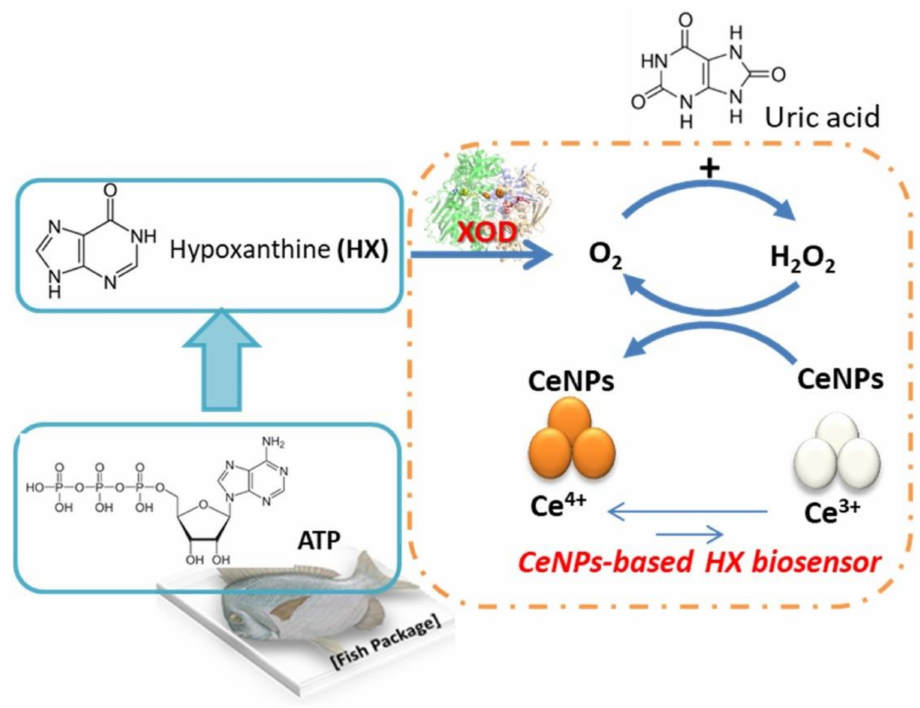
Figure 12. Ceria NPs (CeNPs) and xanthine oxidase (XOD) for the biosensing of hypoxanthine (HX) to monitor fish freshness. Reprinted from [153], Copyright © 2021, with permission from